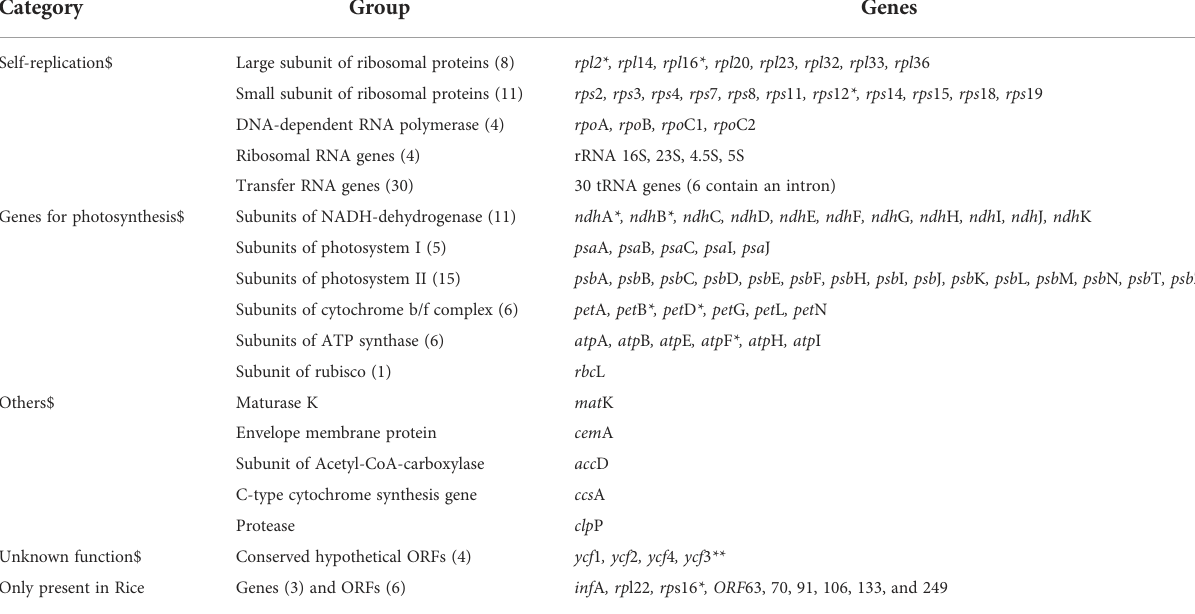
TABLE 1 Annotated genes in cpDNAs.